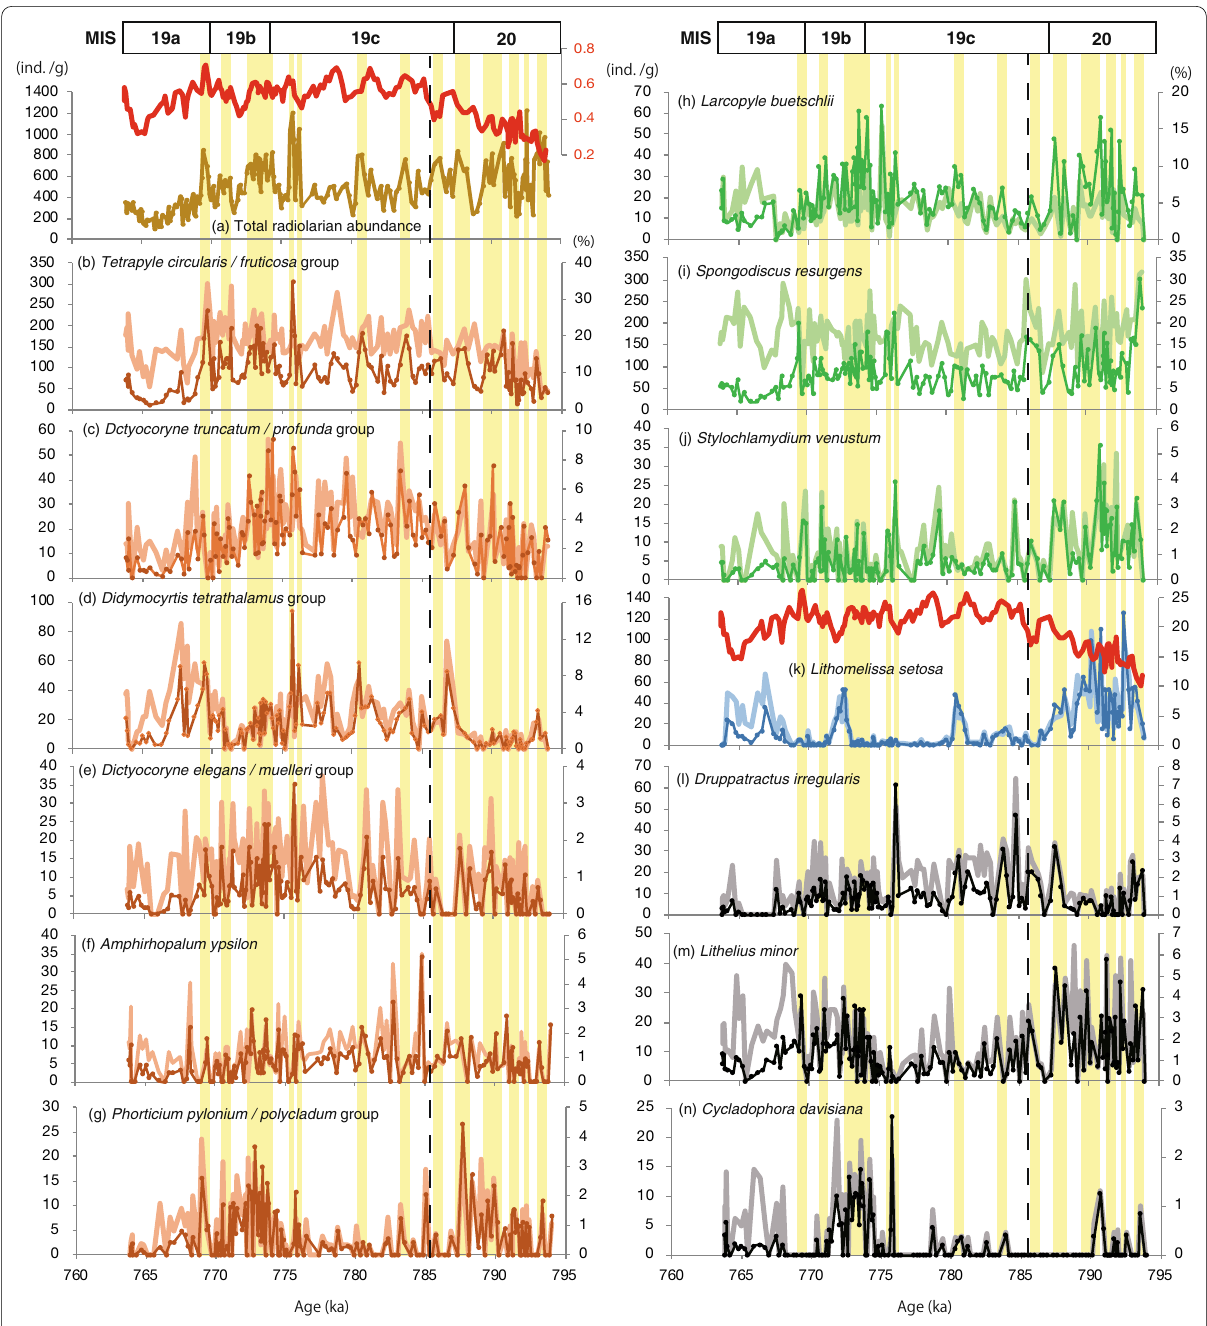
Fig. 3 Variations in absolute abundance (individuals/g) of total radiolarians ( a ) and 13 species and species groups ( b – n ) for 153 samples newly examined in this study (solid lines with dots). Relative abundances (percent) of the total assemblage for each species are also shown as pale bold lines. Reddish brown ( b – g ), green ( h – j ) and blue ( k ) indicate groups related to the Kuroshio water, mixed water and coastal Oyashio water, respectively. Deep-dwelling radiolarians are shown as black lines ( l – n ). The Tr curves (red lines) are overlapped in panels ( a ) and ( k ). Intervals of the total radiolarian maxima are shown as yellow vertical